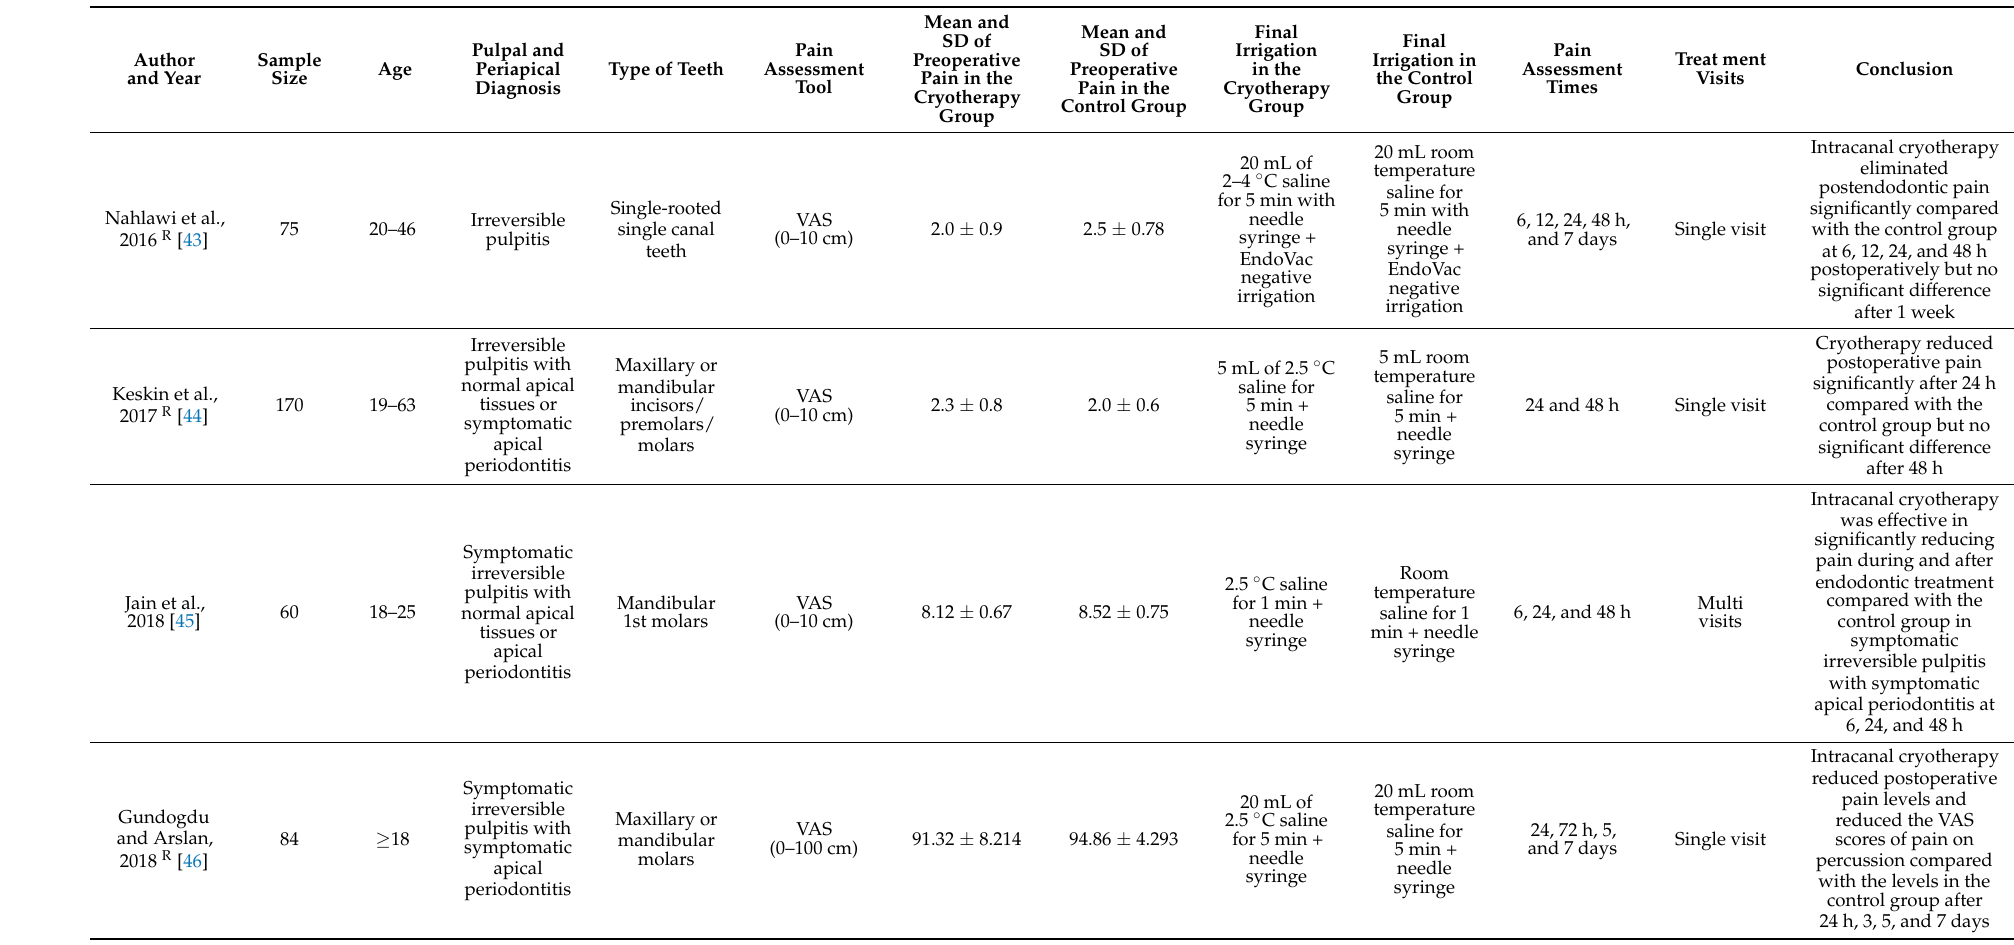
Table 1. Summary of the main characteristics of the included